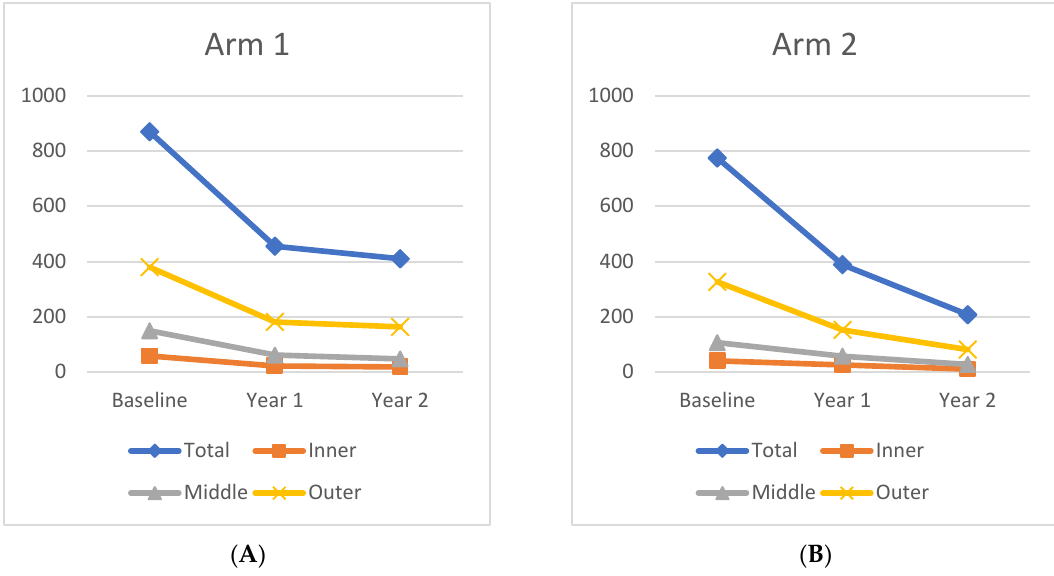
Figure 5. Change in microaneurysm count over time for ( A ) Arm 1 and ( B ) Arm 2 in each region .